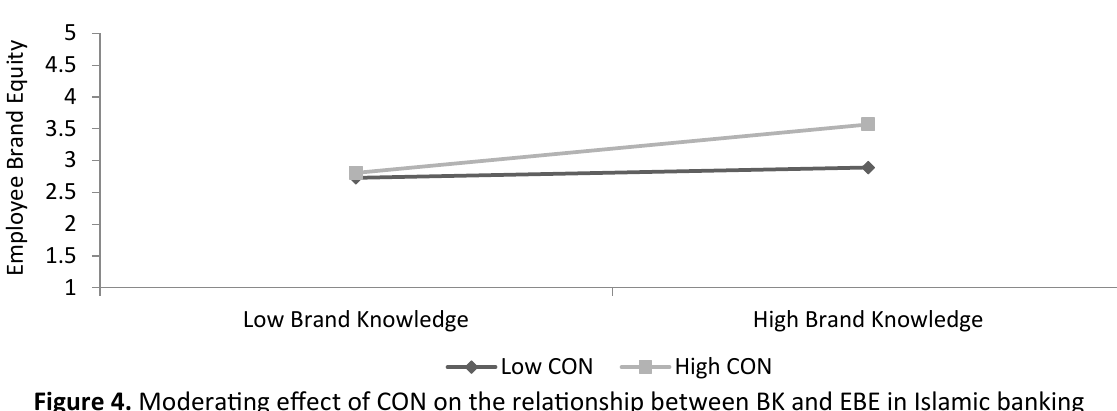
1.522.533.544.55 1 Figure 2. Moderating effect of CON on the relationship between BC and EBE in conventional banking Figure 3. Moderating effect of RES on the relationship between BK and EBE in conventional banking Figure 4. Moderating effect of CON on the relationship between BK and EBE in Islamic banking